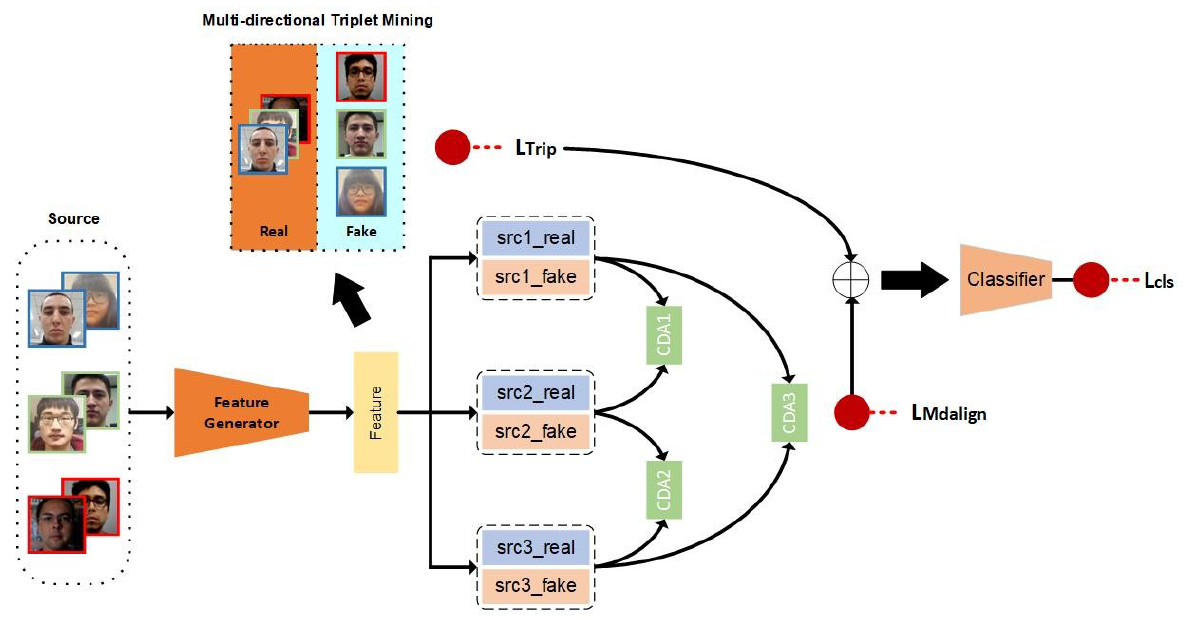
Figure 2. Overview of the proposed method. The proposed method is depicted in the figure, where different domains are delineated by colored borders. The method is exemplified using three source domains. Real and fake face features are obtained from all domains using the same feature